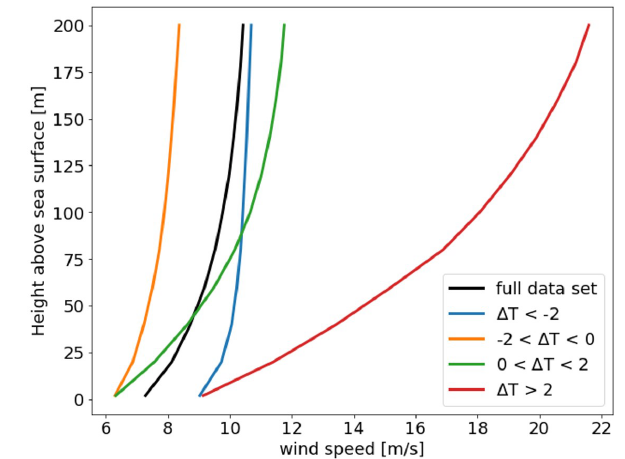
Figure 4. Vertical profiles of mean wind speed calculated from 12 months of buoy-based lidar observations, for four different cat- egories of (cid:49)T = T 2m − SST. Temperature differences are in K (DNV-GL,